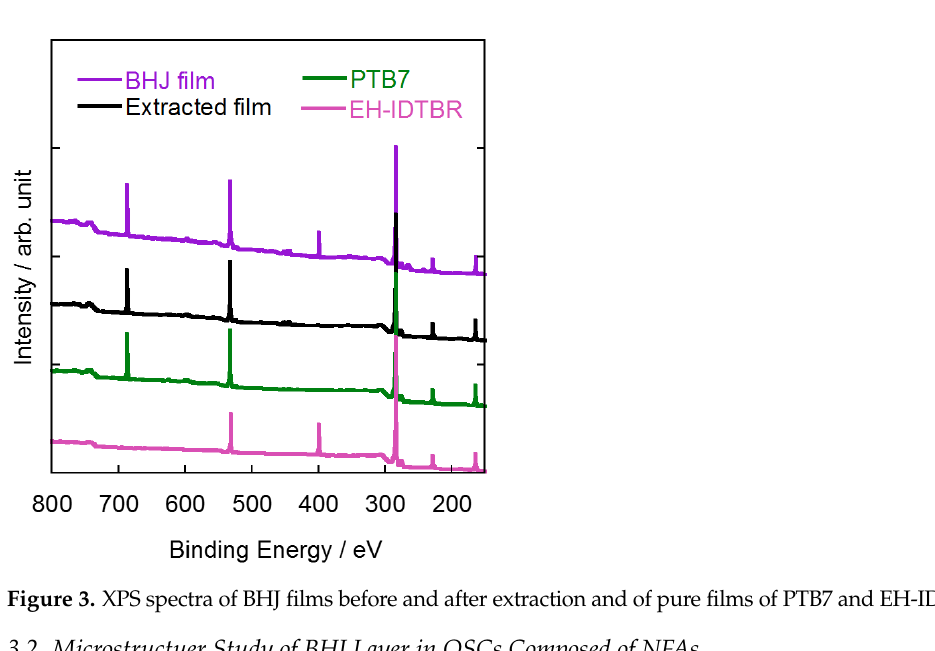
Figure 2. Absorption spectra of thin films of PTB7 and EH-IDTBR ( a ) and spectra obtained after extraction of EH-IDTBR from blend films (before: purple, after: black) using various organic solvents ( b ): n-hexane, ( c ): DMF, ( d ): THF, ( e ): DCM,